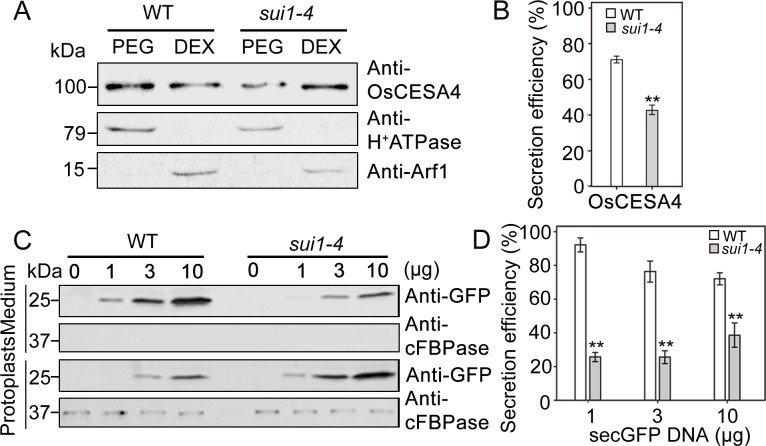
sui1-4 is a secretion disorder mutant.(A) Fractions of membrane proteins extracted from 2-week-old WT and sui1-4 plants immunoblotted with anti-OsCESA antibody. Anti-H+ATPase and anti-Arf1 were two marker proteins predominantly present in the plasma membrane and endomembrane fractions, respectively. The dextran (DEX) fraction contains endomembranes; the polyethylene glycol (PEG) fraction contains PMs. (C) Immunoblotting of secreted green fluorescent protein (secGFP) in WT and sui1-4 protoplasts in a transient expression system. Equal amounts of protein extracted from protoplasts and culture medium were detected using anti-cFBPase, a marker for the plant cytosol. Immunoblotting was conducted in triplicate. 0, 1, 3, 10 (ug) represent the amounts of plasmid (SecGFP) when transient expression using rice protoplast. (B) and (D) Quantification of protein secretion in (A) and (C) relative to total protein (defined as 100%) using ImageJ. Three independent experiments were performed to obtain the average secretory efficiency. Differences were significant (**p<0.01, Student’s t-test). Error bars indicate standard deviation.